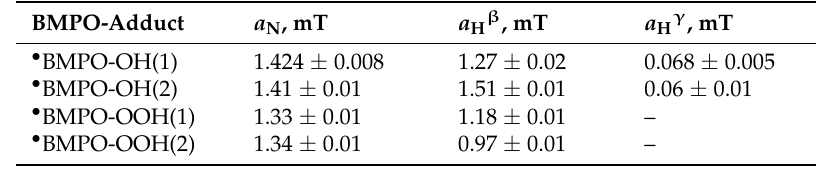
Table 1. Hyperfine coupling constants of the BMPO spin adducts elucidated from the simulations of experimental spectra measured in the buffer solutions. • BMPO-OOH and • BMPO-OH were simulated based on two conformers.